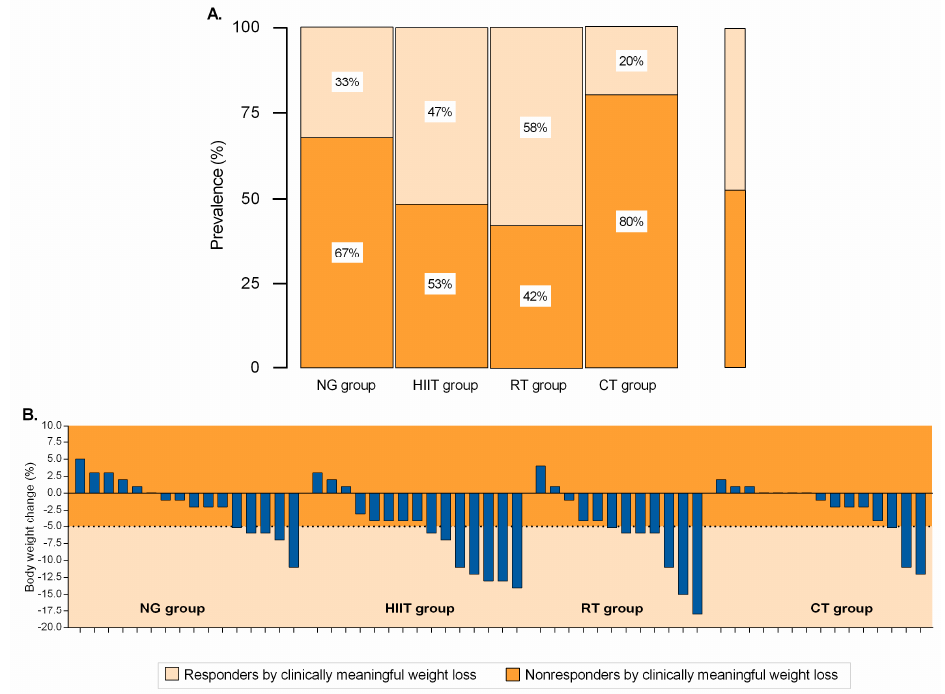
Figure 2. Categorical (Panel A ) and data of all individual subjects (Panel B ) for the intervention group at week 12, based on weight loss of ≥ 5%. Responders by clinically meaningful weight loss is illustrated by the lighter shaded area. Values within the darker shaded area represent nonresponse. NG: nutritional guidance alone group; HIIT: high-intensity interval training group; RT: resistance training group; CT: combined training (HIIT + RT)